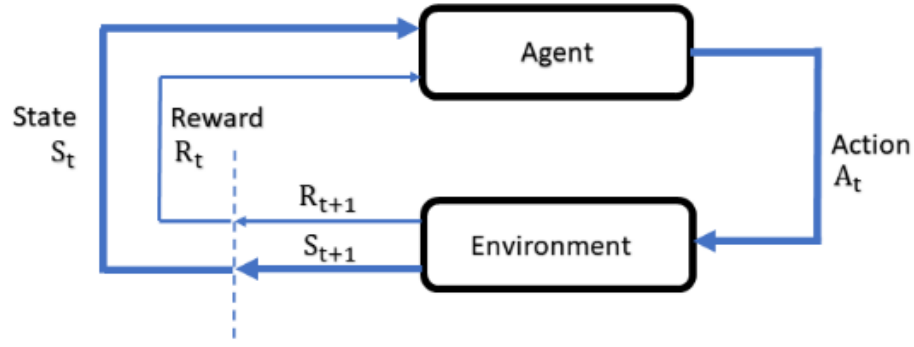
Figure 5. Markov decision process flow.